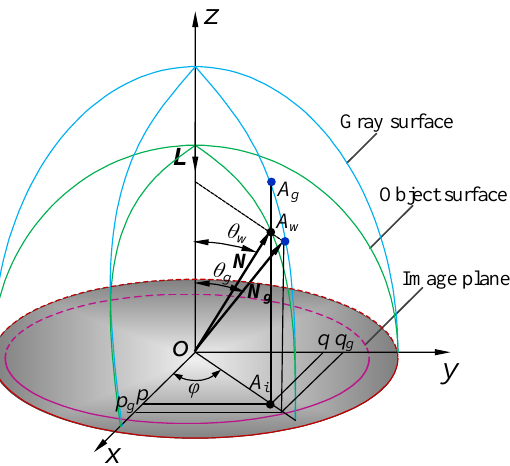
Figure 2. Analytic reconstruction principle.